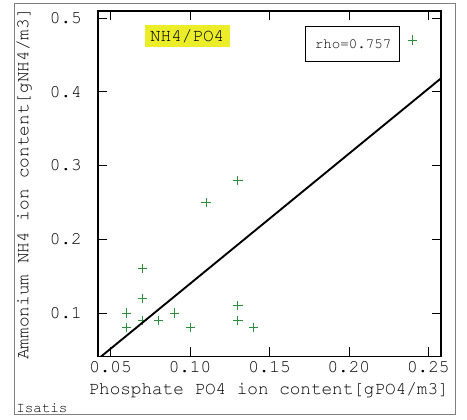
Fig. 11. Diagram correlation of iron Fe ++ content [g Fe ++ /m 3 ] and total organic coal C (OWO) [g C/m 3 ] in underground water, with the marked regression line Y / X in the area of water intake in the region of Kłodzko (14 wells)